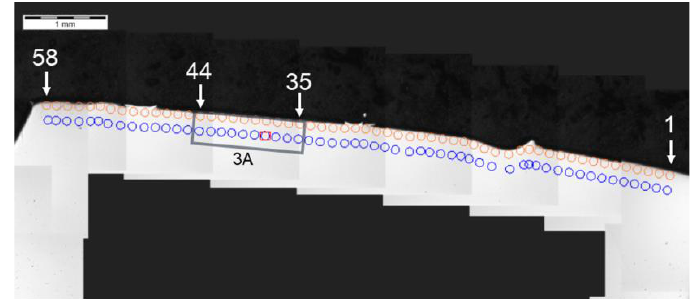
Figure 8. Localization of cross-section F-F, zone: 3A.